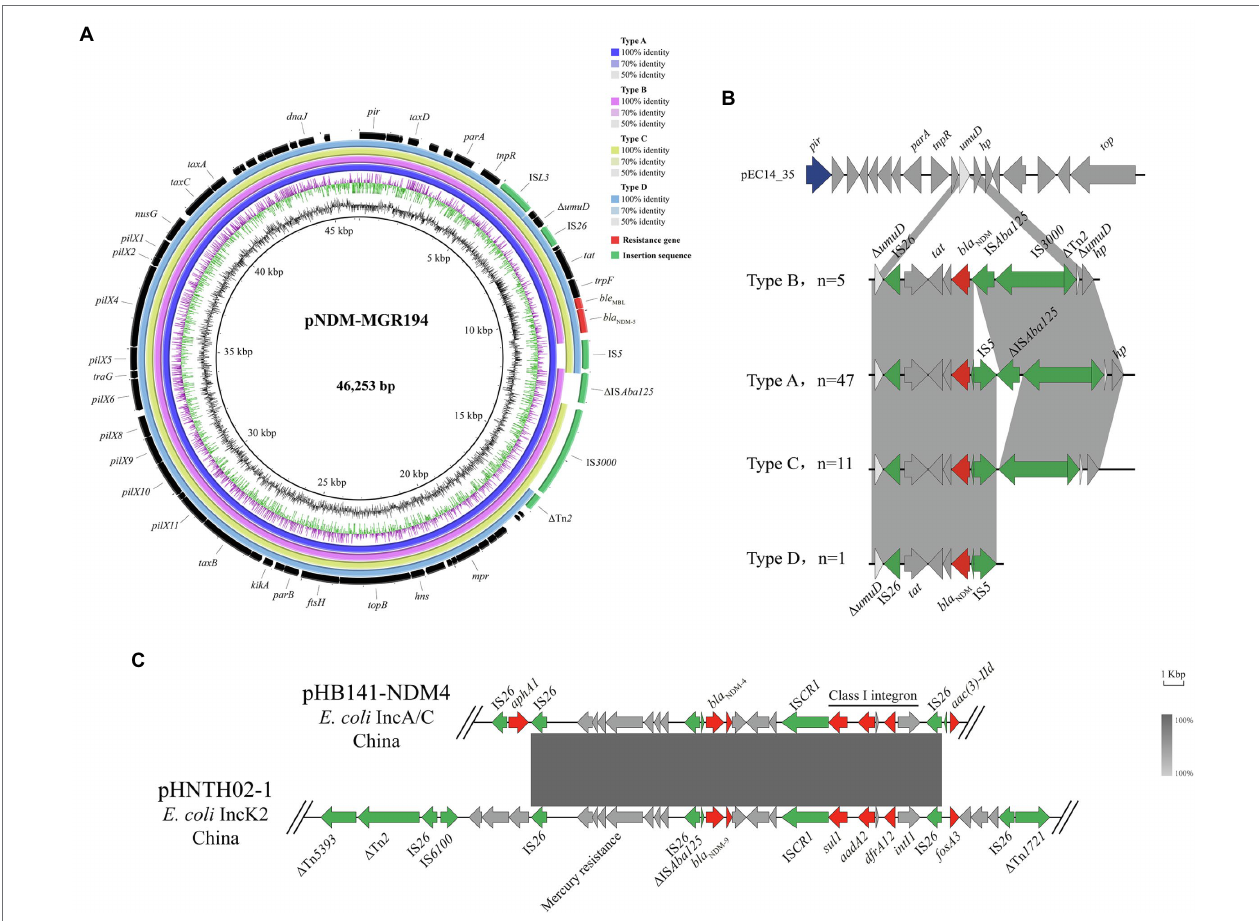
FIGURE 3 | Genetic environments for bla NDM . (A) Comparison of bla NDM-5 -carrying IncX3 plasmids with reference sequence pNDM-MGR194. (B) Four different genetic environments on the IncX3 plasmid harboring bla NDM. (C) Linear sequence comparison of pHB141-NDM4 and